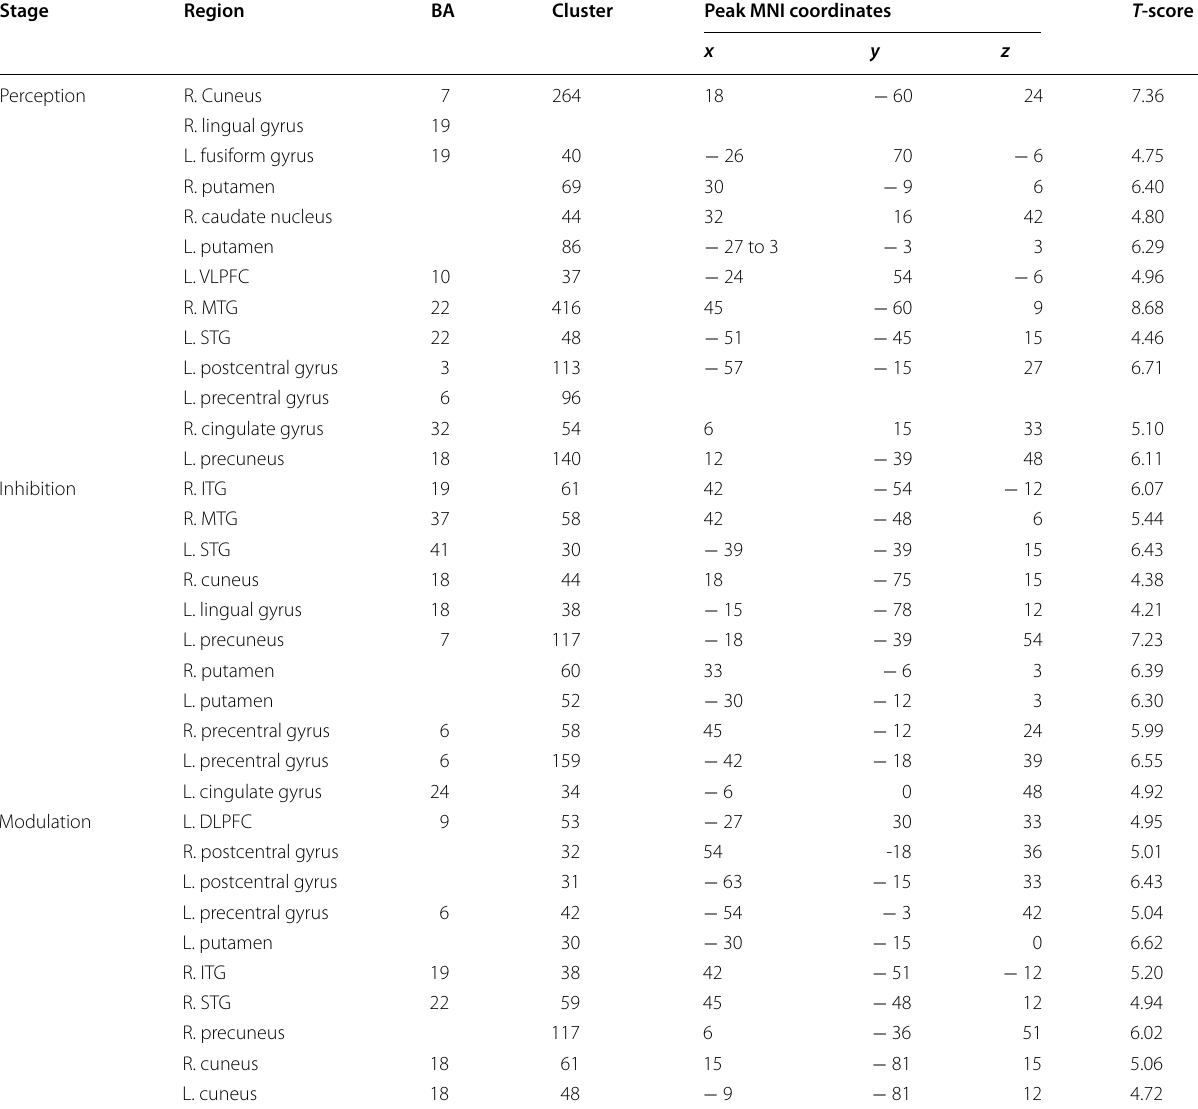
Table 2 Activated regions revealed by the paired t -tests